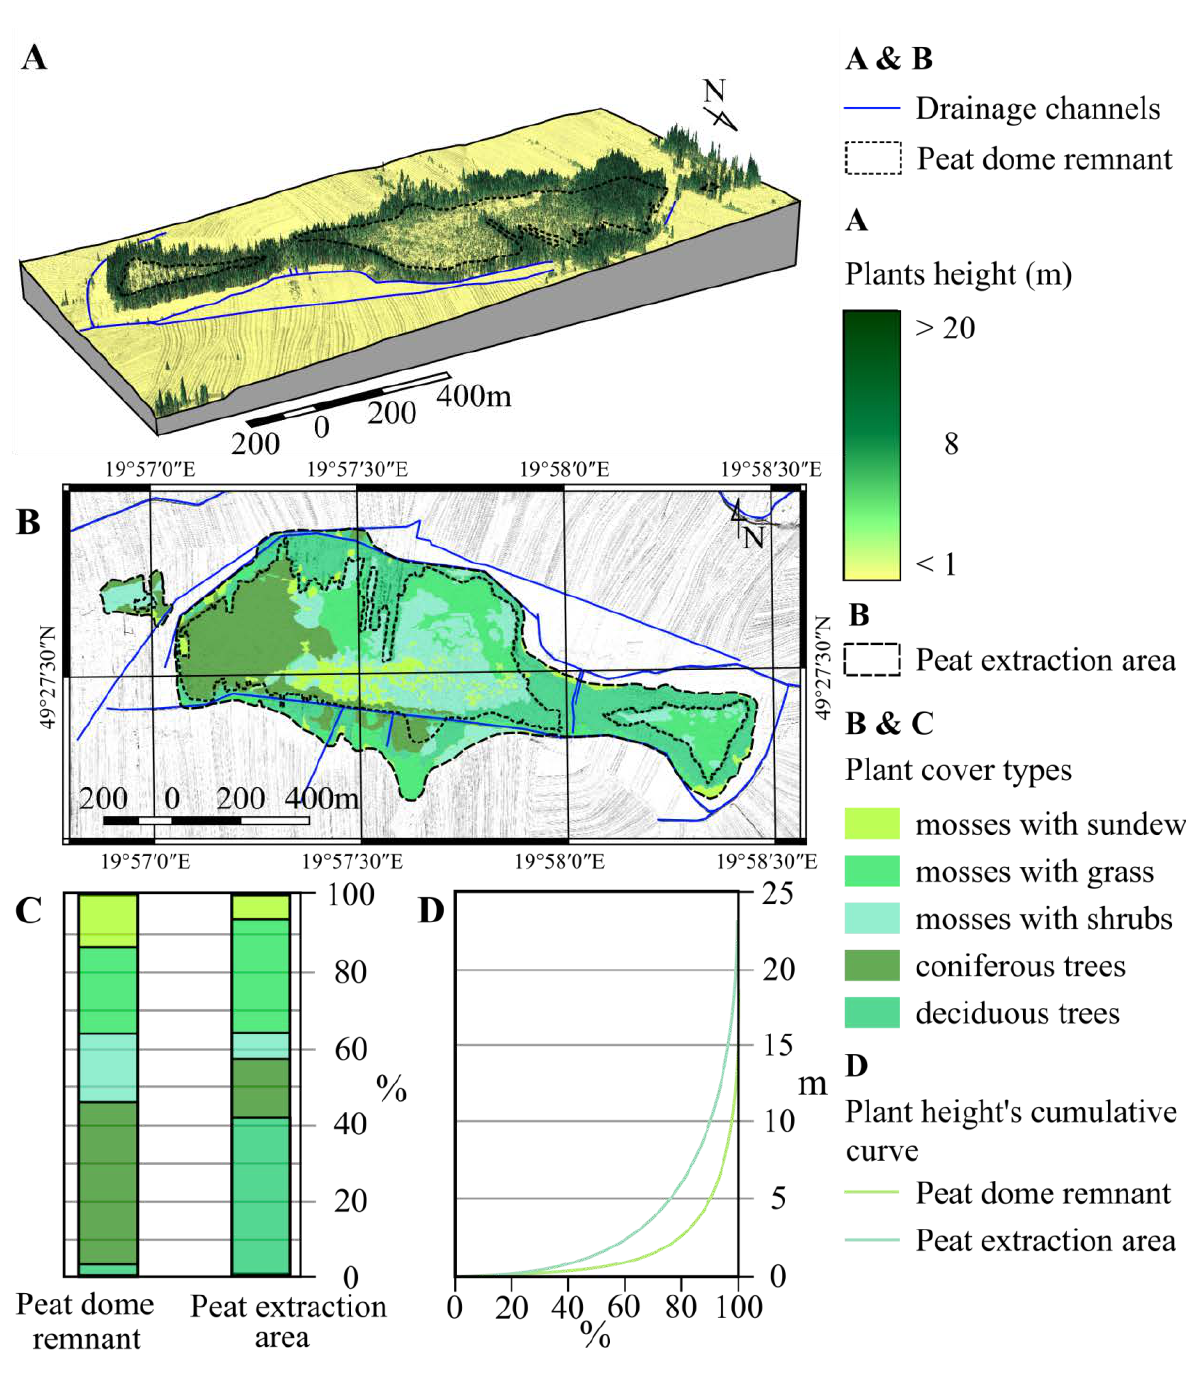
Figure 5. Characteristics of vegetation on the Ludźmierz bog from ALS data and the orthophotomap of Poland. A: differential model of vegetation height on the bog; B: vegetation types occurring on the bog; C: diagram showing the shares of different vegetation types on the dome and cutover areas; D: cumulative graphs of the relative (%) surface areas of domes and cutover occupied by vegetation of given stature (m). The NDVI values calculated on the basis of RED The values of the index increase in the west and and IR channels also differ between the domes and south-east parts of the middle dome remnant, due to peat extraction areas (Figure 6D). The NDVI values the encroachment of trees into the dome area. The are lower on the domes than on the peat extraction extent of the eastern dome is discernible because the areas, by an average of 0.15 units. This difference is NDVI values there are lower than in the peat statistically significant (χ 2 = 17.023; df = 5; p > 0.05). extraction